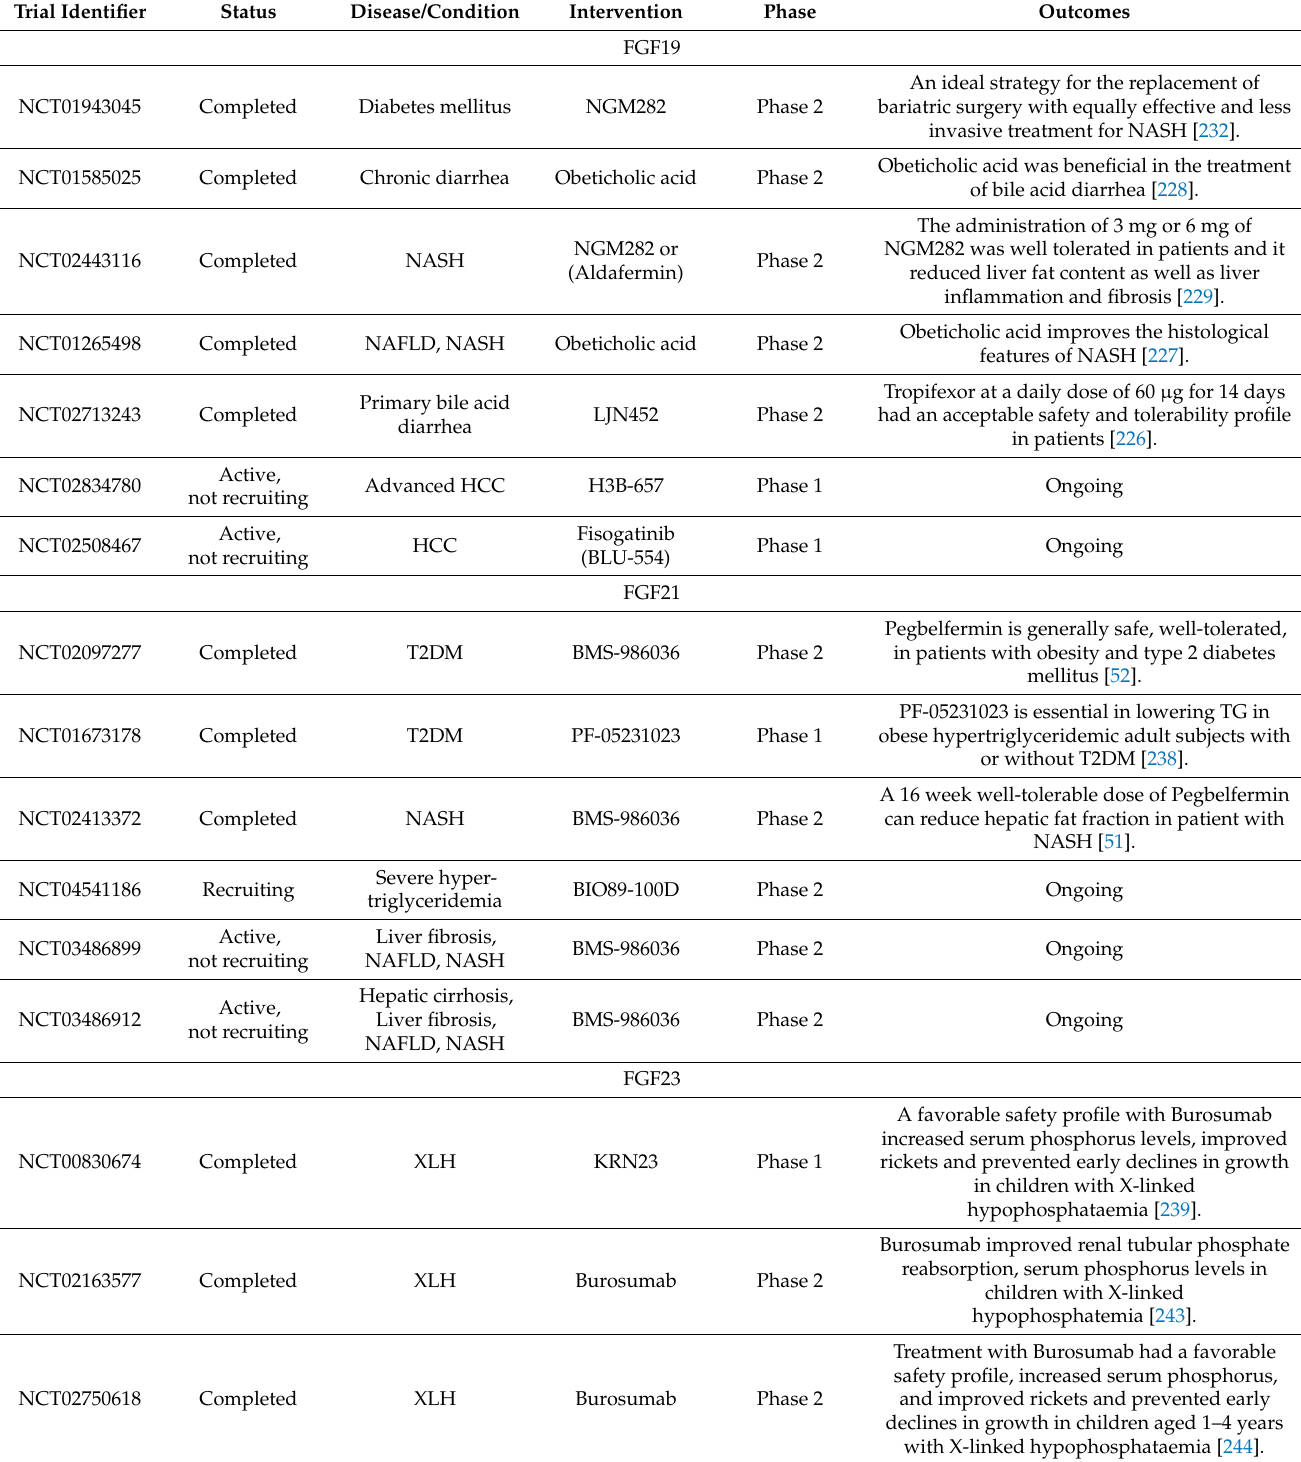
Table 1. Key examples of endocrine FGF analogs and antagonists in clinical